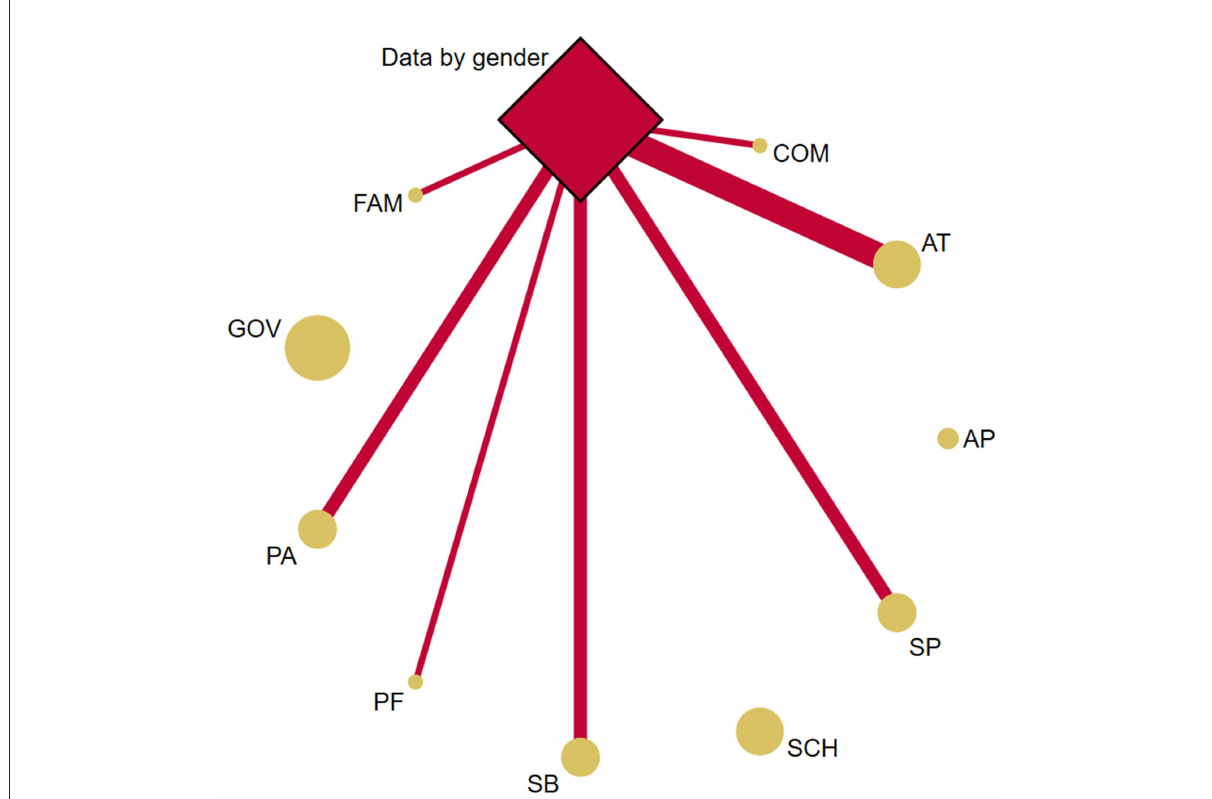
FIGURE4 Network geometry plots of available comparisons between the PA-related indicators and gender data. The size of the circular nodes (PA-related indicators) was relative to the number of papers analyzing these components. The size of the diamond nodes (gender data) was relative to the number of available data on PA-related indicators analyzing these components. The width of the solid line connecting the nodes was relative to the number of papers analyzing the PA-related indicators (circular nodes) according to gender data (diamond nodes). AP, Active play; AT, Active transportation; COM, Community and built environment; FAM, Family and Peers; GOV, Government; PA, Physical activity; PF, Physical fitness; SB, Sedentary behavior; SCH, School environment; SP, Sport and physical activity